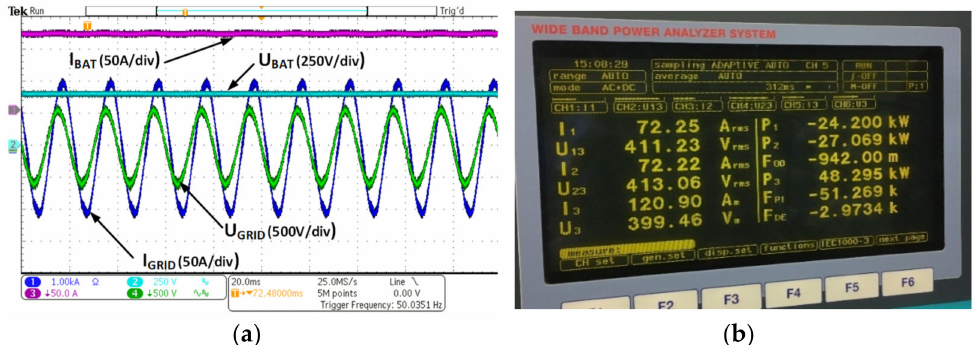
Figure 13. Operation of unidirectional charger under nominal conditions—steady state: ( a ) current and voltage waveforms, from the top: battery current (purple), battery voltage (light blue), AC phase current (dark blue), AC line-to-line voltage (green); ( b ) printed screen from the LEM NORMA Power Analyzer.